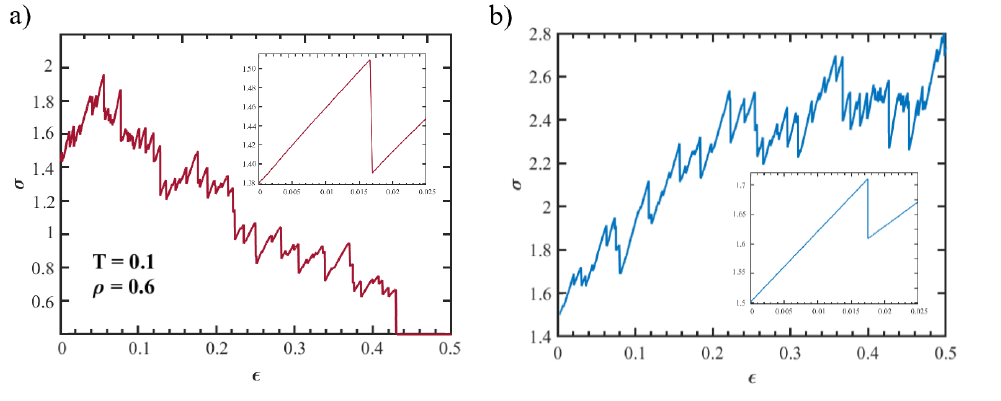
Figure 3. Stress–strain curves for a system at T = 0.1, ρ = 0.6 and age t = 10 in the case of compressive (panel a ) and tensile (panel b ) loading. The insets are magnifications of the elastic regions at a small rate of